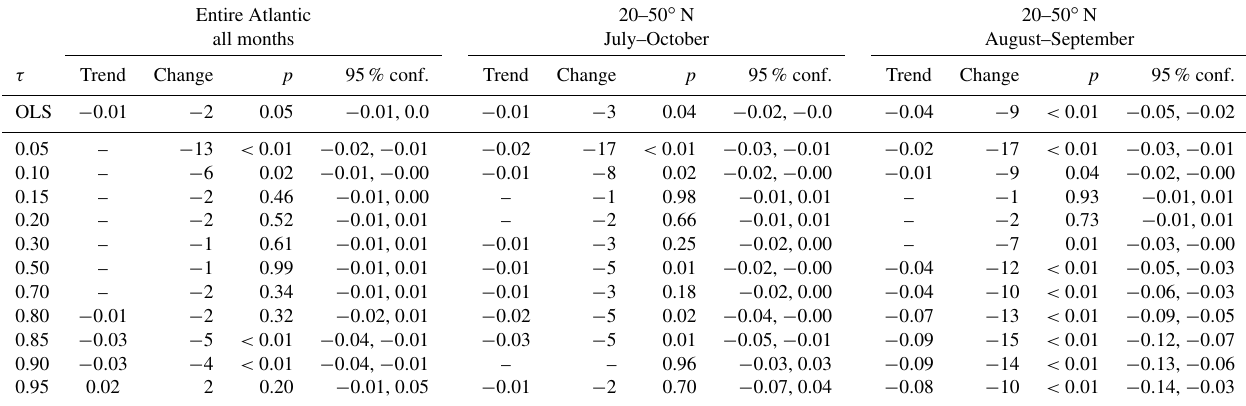
Table 5. Quantile trends of translation speed over 1966–2019 (kmh − 1 yr − 1 ) for months and regions labeled below. Trends of magnitude below 0.01 are not